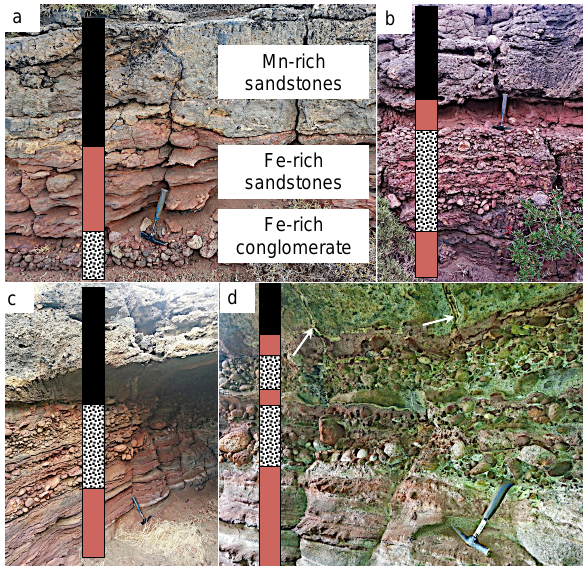
Figure 5. Sedimentary sequence overlying the MFIF, consisting of thin ( < 0.5m) polymictic andesite–dacite cobble–pebble, and sandstone–sandy tuff pebble and Fe-rich conglomerate facies over- lain by thinly laminated Fe-rich sandstone beds. This vertical se- quence is interpreted as representing a progressively deeper water environment up the sequence (a) , for reasons including sea level rise due to tectonic subsidence. The multiple cycles in (b) – (d) sug- gest potential episodes of sea level change. Arrows in (d) show hy- drothermal feeder veins feeding the overlying layers. The sequence is overlain by a thin package of parallel and cross-bedded Mn sand- stone cap.